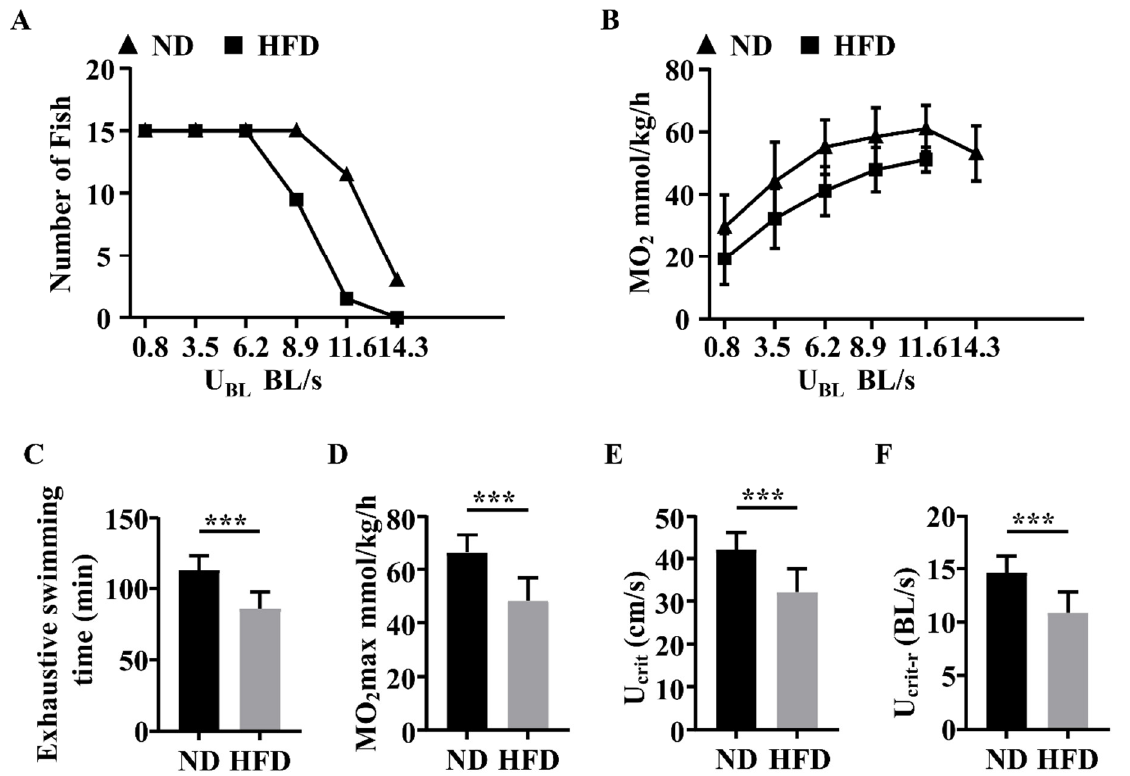
Figure 3. Comparison of swimming capacity tests between the two groups of zebrafish. ( A ) The number of zebrafish in the two groups at each speed test stage. ( B ) MO 2 levels in the two groups at each testing stage. ( C ) Exhaustive swimming times of zebrafish. ( D ) MO 2max of zebrafish. ( E ) U crit of zebrafish. ( F ) U crit-r of zebrafish. ***, p < 0.001. Data represent means, and error bars represent standard errors of the means. Scale bar, 20 µ m. ND, normal diet; HFD, high-fat diet; U crit , critical swimming speed; MO 2 , oxygen consumption.